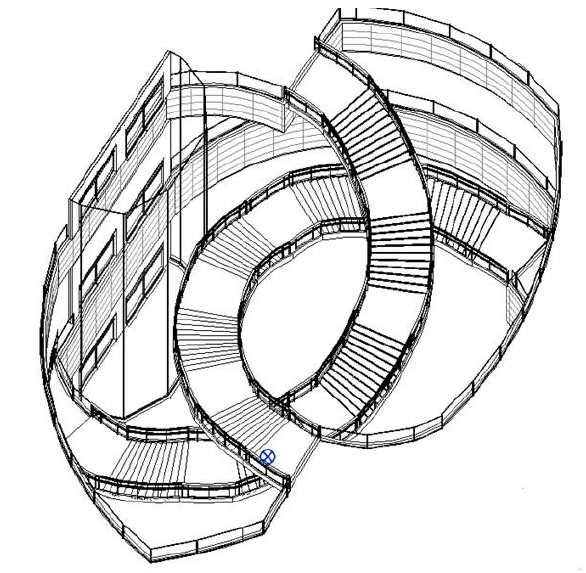
Figure 6. Completed model of as-built